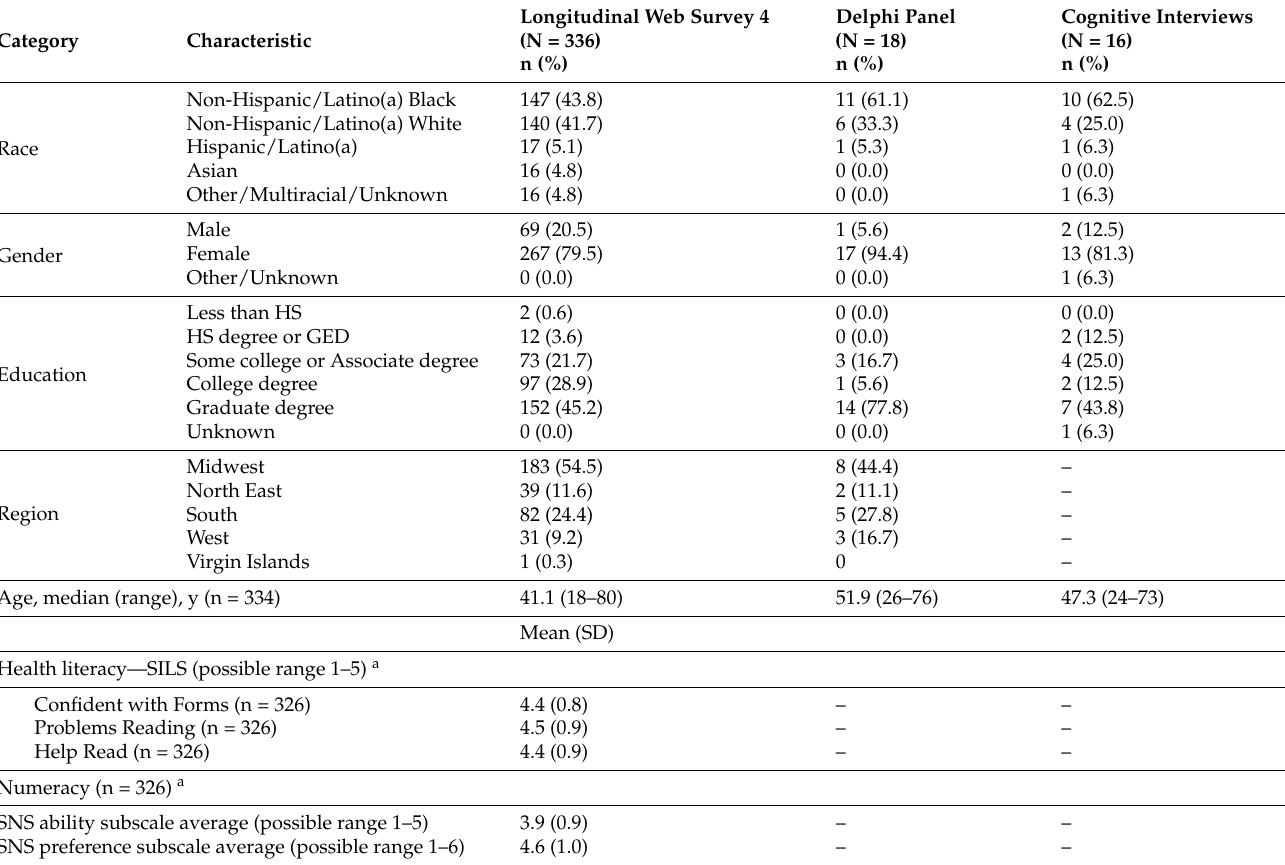
Table 1. Demographic Characteristics of Participants Who Completed Longitudinal Web Survey 4, Delphi Panelists, and Cognitive Interview